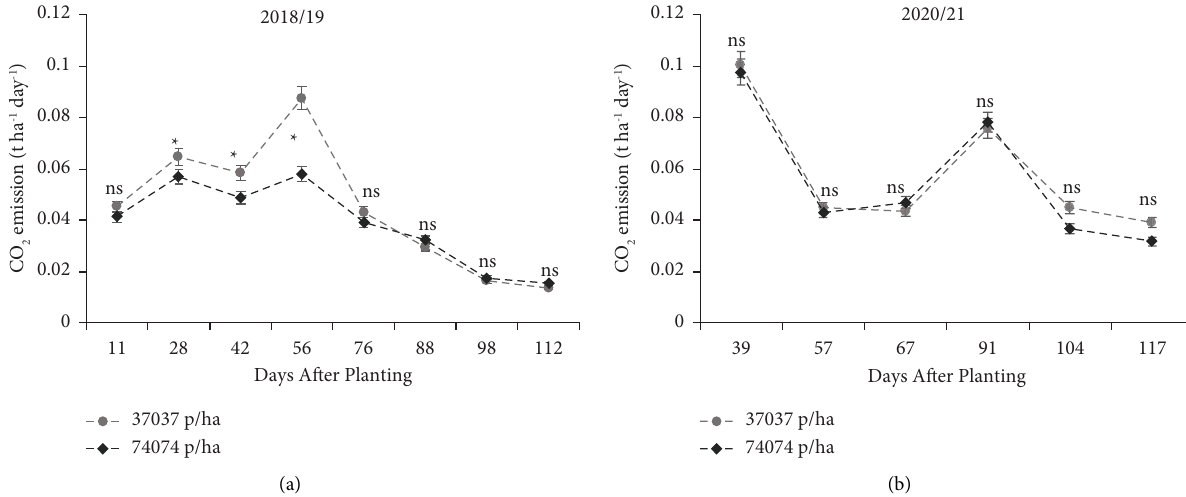
Figure 9: CO 2 emission rate in low and high density of cowpea at Syferkuil during the 2018/19 and 2020/21 cropping seasons. ns signifcant; ∗ � signifcant at p ≤ 0.05.